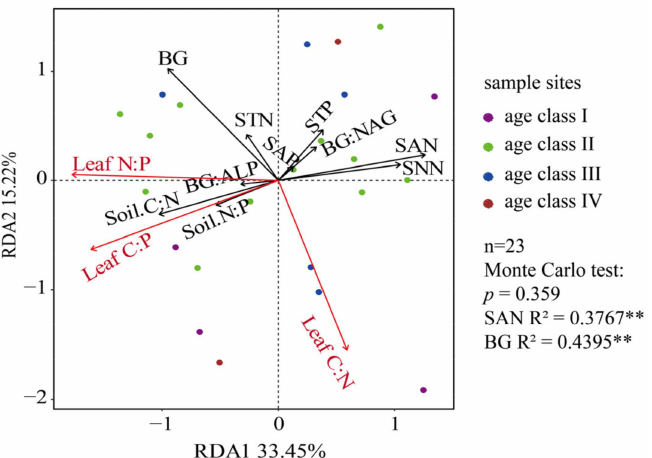
Figure 7. Redundancy analysis (RDA) showing the relationship between soil system variables and leaf stoichiometries. The overall RDA result was not significant with 999 permutations ( p = 0.359). The constrained variables explained 48.73% of the total variance. (**) represent significant correlations at 0.01 level.